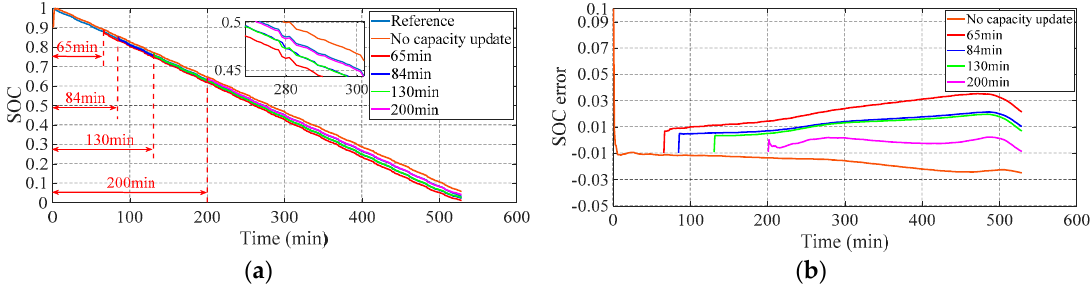
Figure 7. The results of SOC estimation based on various data lengths: ( a ) SOC estimation results; ( b ) SOC error.